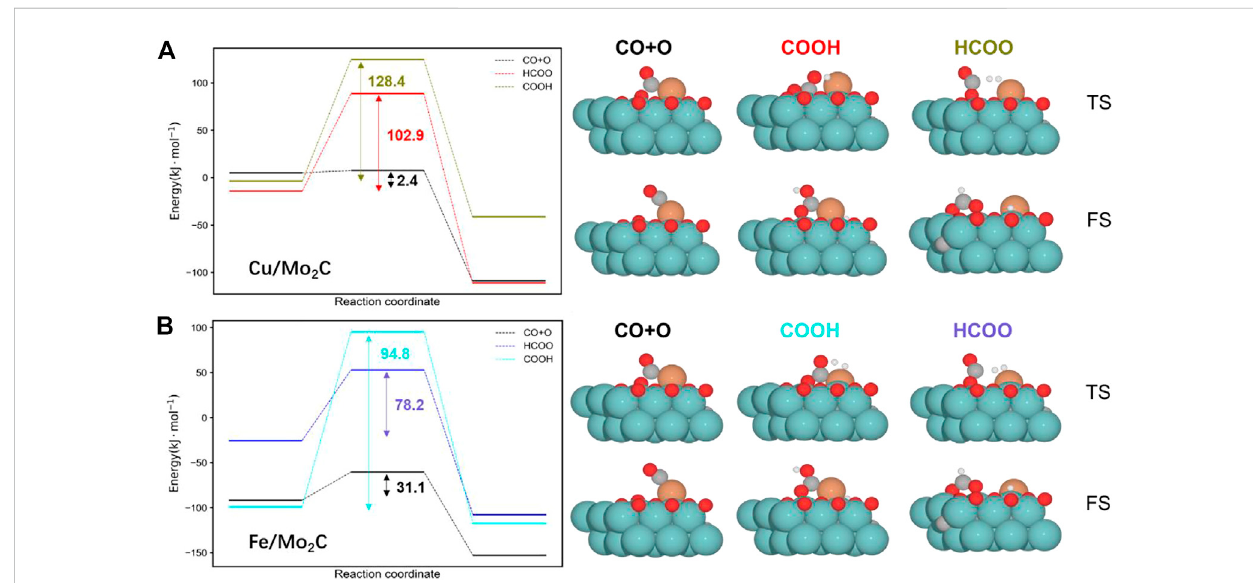
FIGURE 3 Energy pro fi les for the Cu/Mo 2 C (A) and Fe/Mo 2 C (B) systems comparing the direct CO 2 cleavage (CO + O), that is, the redox pathway and the formation of formate (HCOO) and carbonyl (COOH) intermediates. The energy barriers are reported within each pro fi le (black indicates the lowest pathway foreachsystem).The optimizedstructures for thetransitionstate(TS)and fi nalstate(FS)structures areshownnexttothecorrespondingenergy pro fi les. Energies are referenced against the sum of the initial reactants ’ energy in kJ mol – 1 (E rel